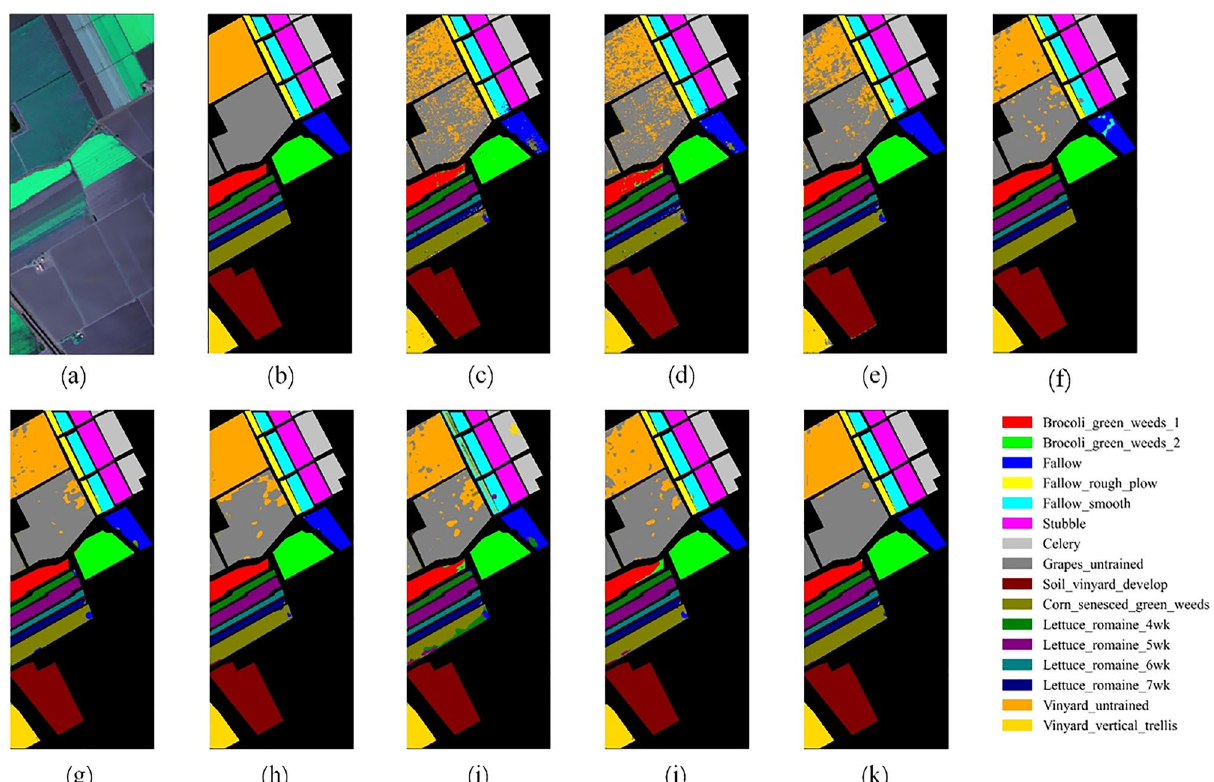
Figure 13. Classification maps of different models on the SA dataset. ( a ) False-color image. ( b ) Ground-truth map. ( c ) MLP. ( d ) 1D-CNN. ( e ) M3D-DCNN. ( f ) SSRN. ( g ) pResNet. ( h ) DBDA. ( i ) SCFR. ( j ) DPSCN. ( k )